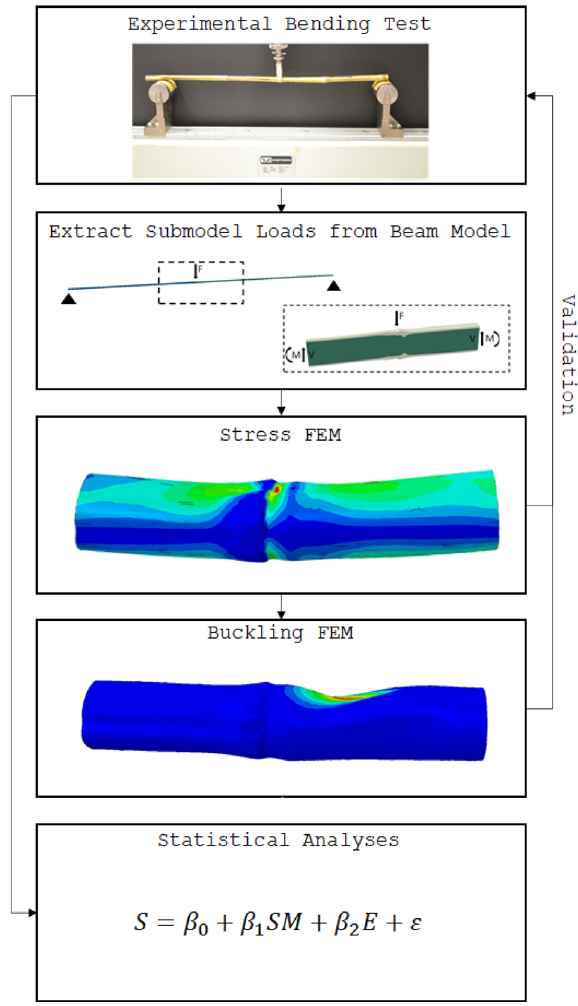
Figure 2. Diagram illustrating the primary components of this study.